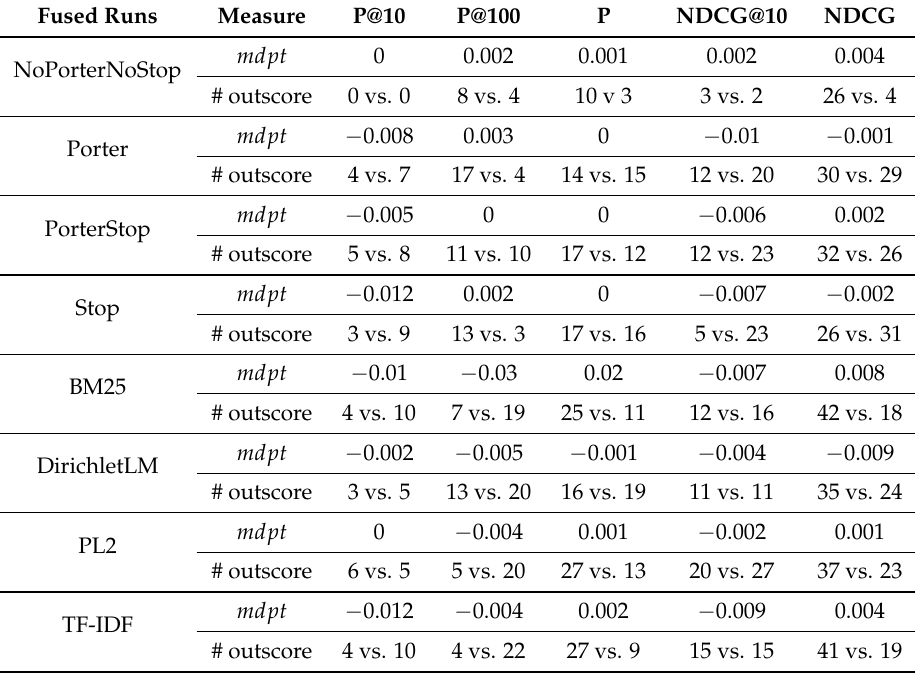
Table 19. T1: scores to find the best fusion, CombSUM vs. RR.